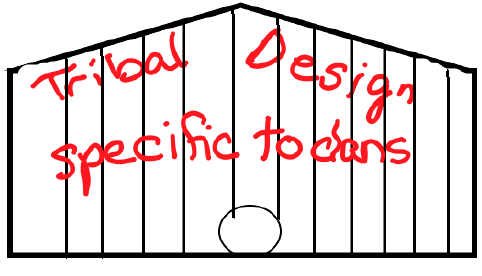
Figure 4. Illustration of Nisga’a longhouse.